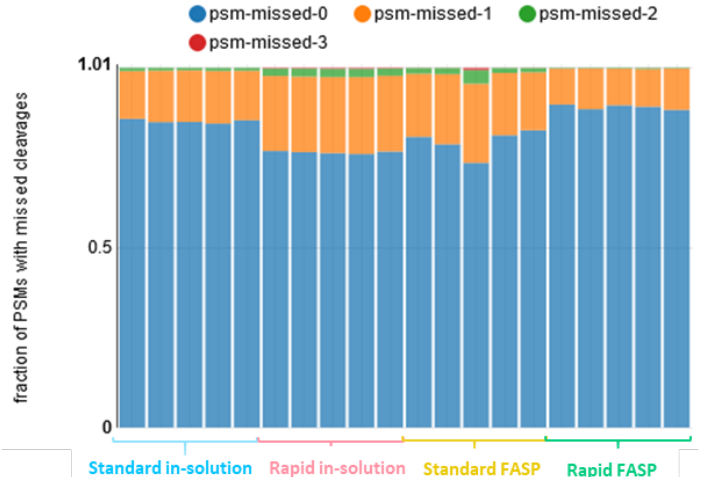
Figure 6. Distribution of PSMs based on missed cleavages. Distributions of the PSM fractions containing 0 (psm-missed-0), 1 (psm-missed-1), 2 (psm-missed-2), and 3 (psm-missed-3) missed cleavages were analyzed. The highest percentage of PSMs for peptides carrying missed cleavage sites was shown for the rapid in-solution digestion. Moreover, the standard FASP showed the least reproducible